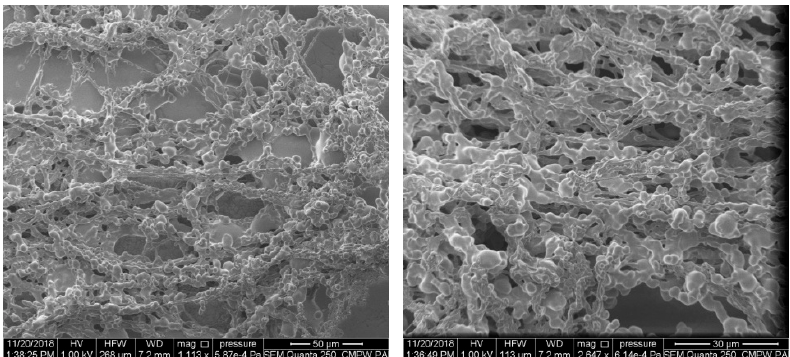
Figure 13. SEM micrographs of P(iPrOx-MOx-EI)2 annealed in water for 12 h at the polymer-rich phase state.